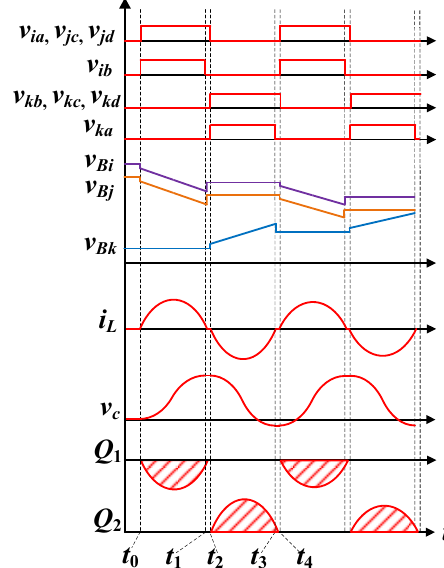
Figure 5. The theoretical waveforms of the enhanced balance mode.